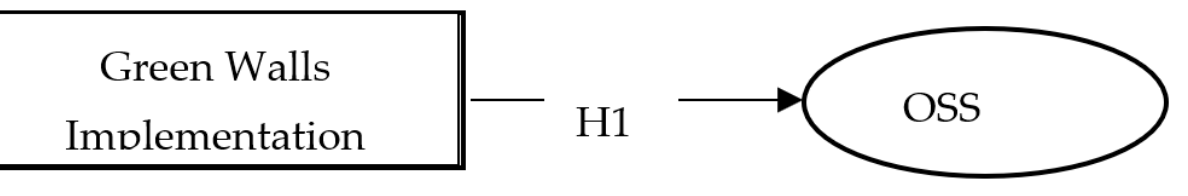
Figure 1. A theorized influence of green walls implementation barriers on the OSS. Table 1. Major deterrents to the adoption of GWs.